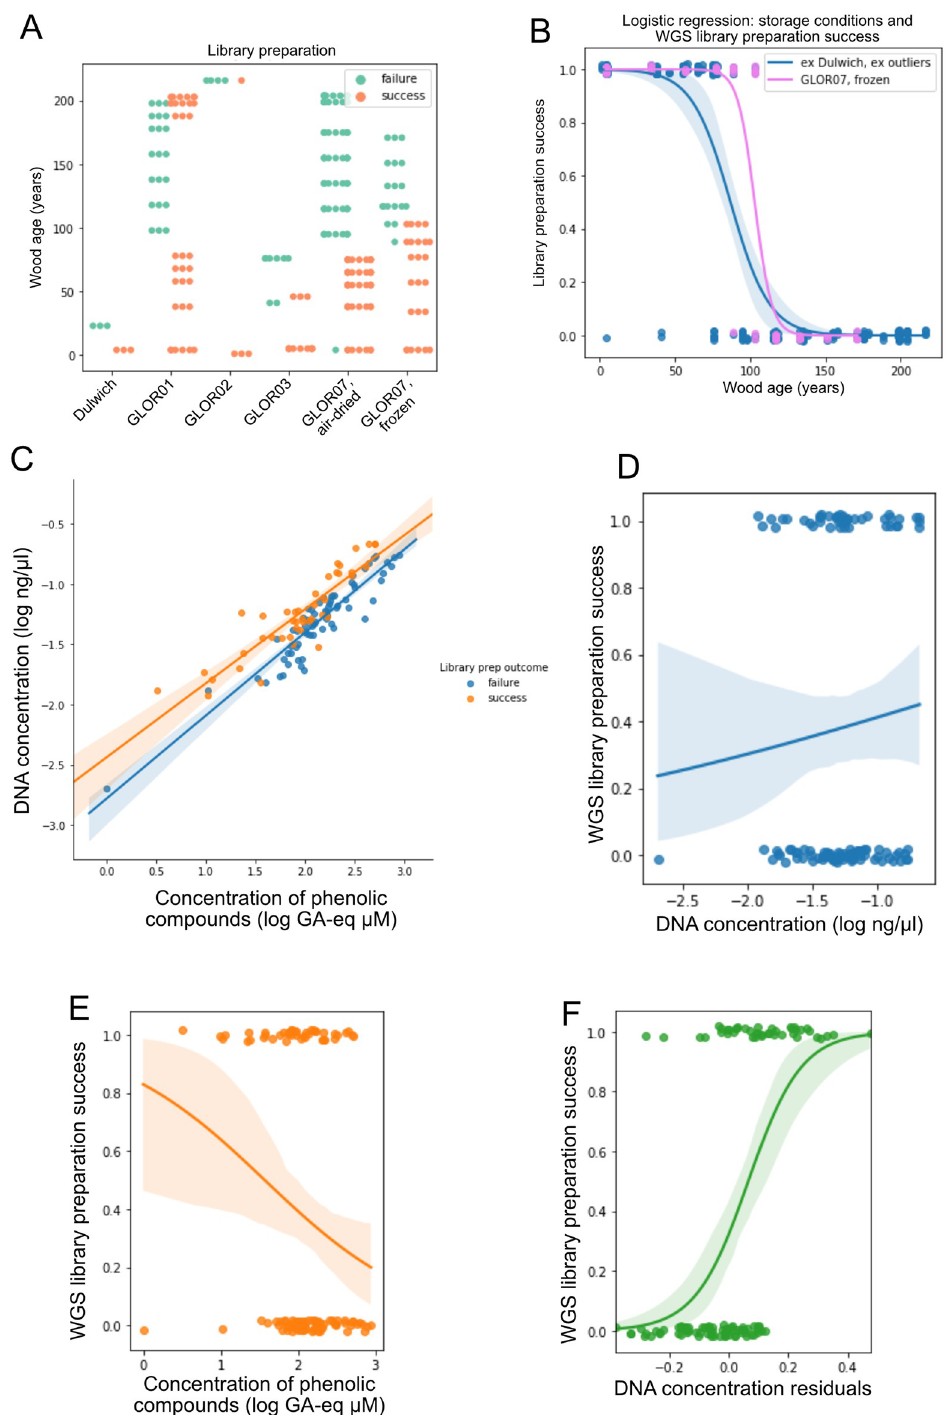
Fig 3. Analysis of the factors affecting the success of DNA library preparation. A) Success of WGS library preparation performed from Dulwich Woods and GLOR01–07 trees (Table 2). Two distinct samples were collected from GLOR07, one was air-dried and stored at room temperature while the other was frozen and stored at -20˚C. B) Logistic regression of the relationship between the age of wood (years) and the WGS library preparation success in GLOR07 frozen samples (“GLOR07, frozen”) and the GLOR01-GLOR07 samples that were air-dried and stored at room temperature (“ex Dulwich, ex outliers”). The logistic regression was performed after excluding (“ex”) the samples